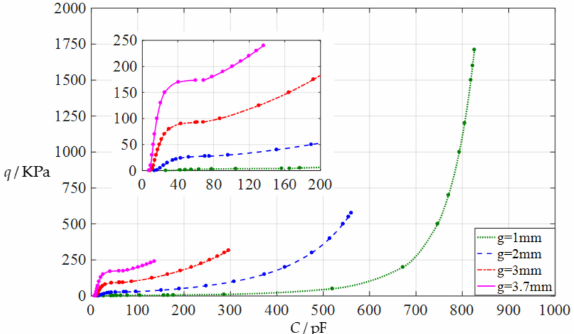
Figure 9. The capacitance–pressure relationships of ten parallel circular capacitive pressure sensors from non-touch mode of operation to touch mode of operation, where a = 10 mm, h = 1 mm, t = 0.1 mm, E = 7.84 MPa, ν = 0.47, and g = 1 mm, 2 mm, 3 mm, and 3.7